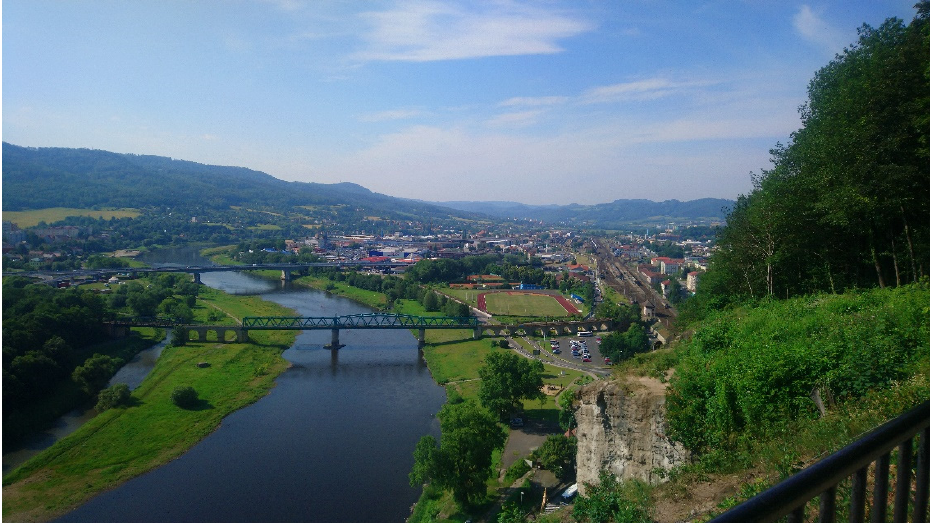
Figure 6. D ěč ín, view from the hilltop Pastý ř ská st ě na to the city centre ( right ) and across the Elbe Figure 6. Dˇeˇc í n, view from the hilltop Past ý ˇrsk á stˇena to the city centre ( right ) and across the Elbe to to the Stezka u Labe ( left ) (photo: R.-U. Syrbe). the Stezka u Labe ( left ) (photo: R.-U.